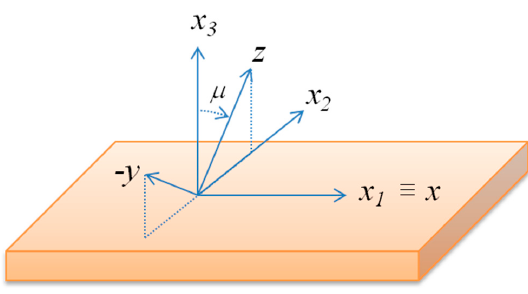
Figure 1. The laboratory coordinate system ( x 1 , x 2 and x 3 ) and the propagating medium Figure crystallographic axis ( x , − y and z ≡ c ); μ is the c-axis tilt angle respect to x 3 .